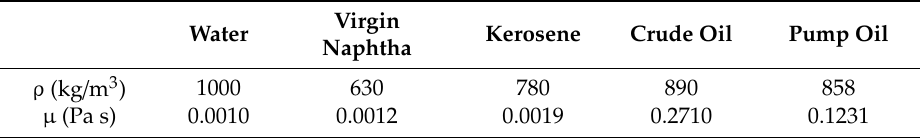
Table 2. Density ( ρ ) and dynamic viscosity ( µ ) of selected